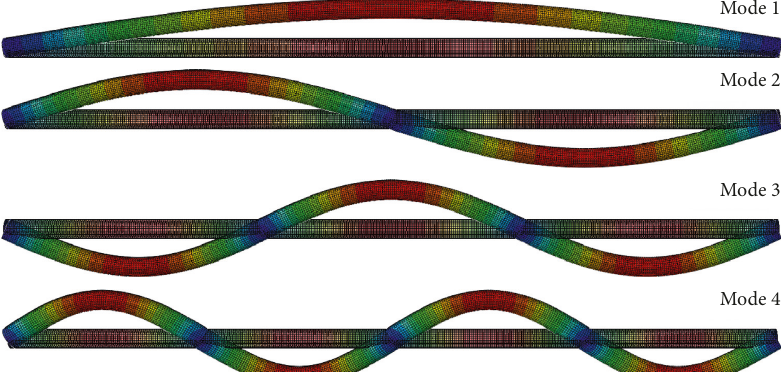
Figure 6: Both first four bending vibration mode shapes and undeformed beams, for a healthy beam, obtained by the finite element model. Table 3: Values of the reference frequency ratios. Pinned-pinned